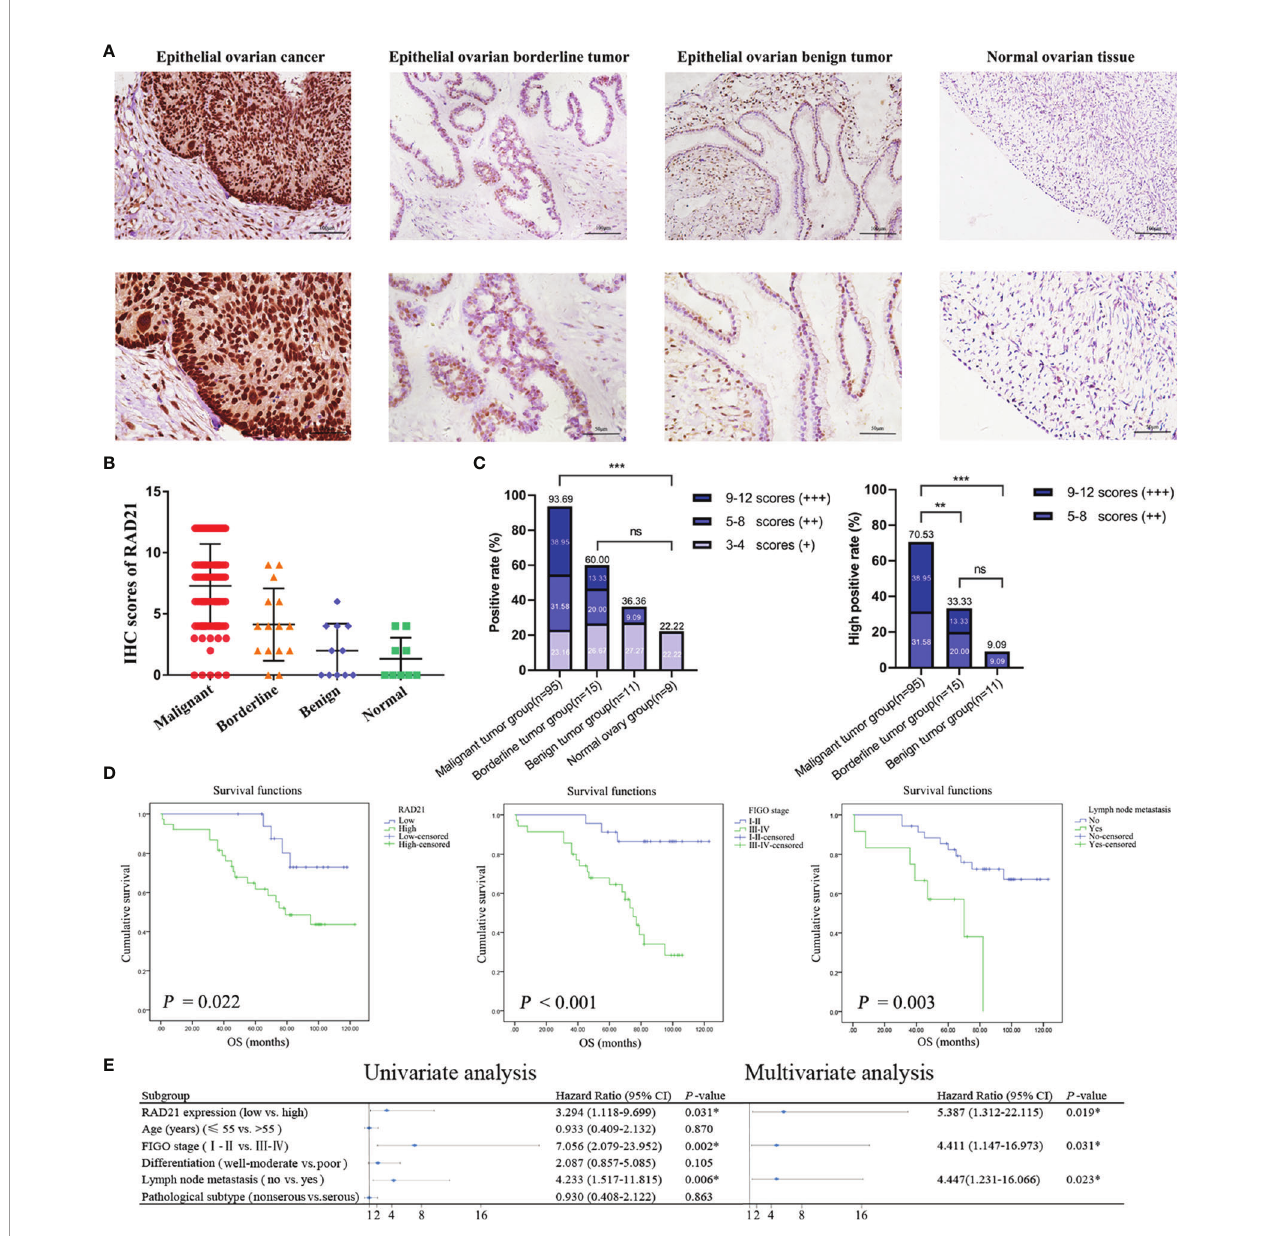
FIGURE 1 | RAD21 expression level in different groups of ovarian tissue and its prognostic value in epithelial ovarian cancer. (A) Representative images of immunohistochemical staining for RAD21 in ovarian tissue samples. Magni fi cation: upper, ×200; lower, ×400. (B) Immunostaining scores of RAD21 in ovarian tissue samples. (C) Statistical analyses of RAD21-positive and high-positive rates in ovarian tissue samples. (D) The relationship between RAD21 expression, International Federation of Gynecology and Obstetrics (FIGO) stage, lymph node metastasis, and overall survival in patients with epithelial ovarian cancer. (E) Forest plot based on Cox regression model analysis of patients with epithelial ovarian cancer. * p < 0.05; ** p < 0.01;*** p < 0.001; ns, not signi fi